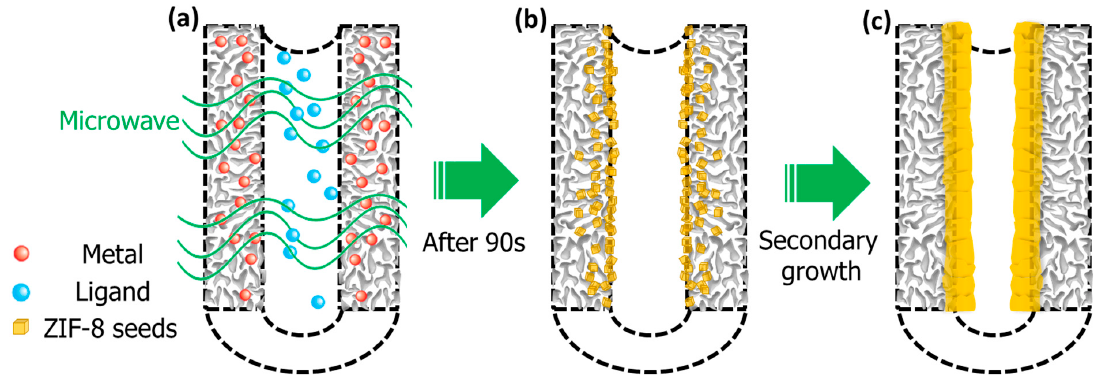
Figure 1. A schematic illustration of ( a ) microwave seeding; ( b ) seeded tube; and ( c ) polycrystalline membrane after secondary growth. ZIF-8—zeolitic imidazolate framework.